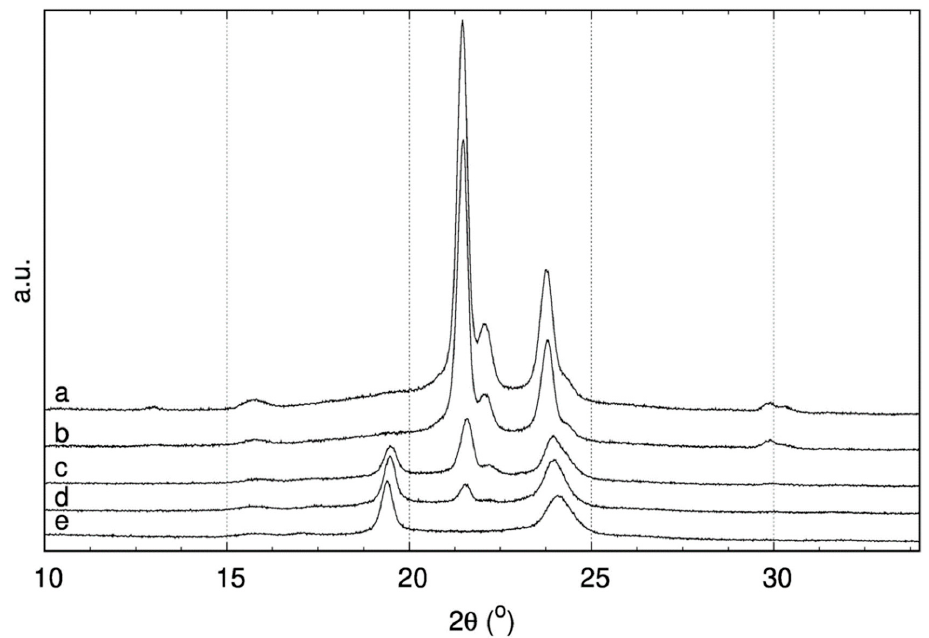
Figure 3. XRD diffractograms of ( a ) PCL, ( e ) PTCL, and COP copolymers with molar proportions of